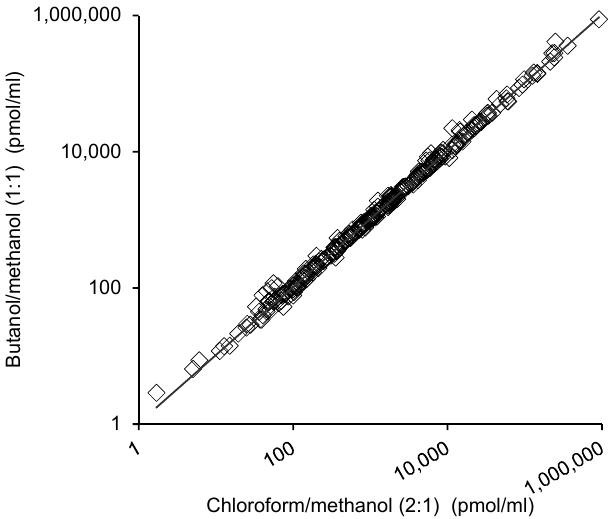
Figure 3. Correlation of plasma lipid measurements following different extraction procedures. Plasma (10 µL, n=10) was extracted via the 1-butanol/methanol (1:1 v/v) or chloroform/methanol methods and analyzed for 293 lipid species via liquid chromatography electrospray ionization-tandem mass spectrometry. The concentration of each lipid was calculated by comparing the area under the chromatogram with the corresponding internal standard. The concentration of each lipid determined via the 1-butanol/methanol (1:1 v/v) method was plotted against the concentration of the same lipid as determined via the chloroform/methanol method. The line of best fit was y = 1.0278x (R² =